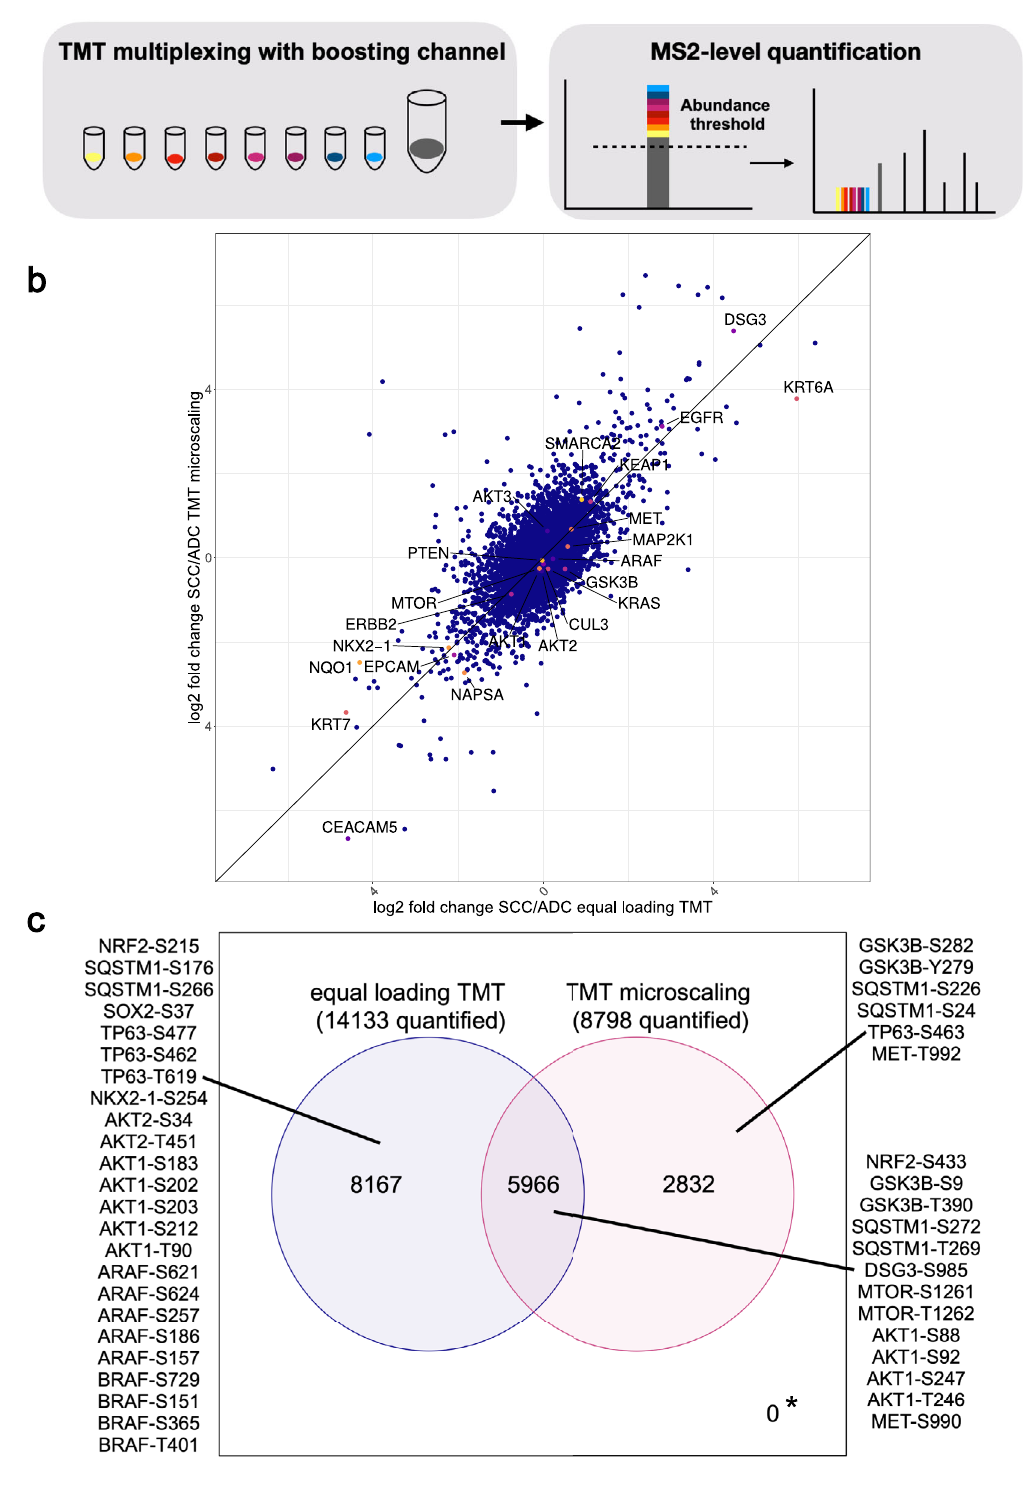
Fig. 4 Deep proteome coverage even from small sample amounts by using a TMT booster sample. a TMT11 combined with a boosting channel allows for microscaled deep proteome and phosphoproteome analysis of FFPE samples with low sample amounts (20 µ g per sample). b Correlation of log2 fold changes of equal loading TMT and micoscaled TMT experiments in FFPE lung cancer samples shows similar quanti fi cation results (Pearson correlation coef fi cient r = 0.67, p < 0.01). NSCLC-relevant proteins are highlighted, all other proteins are shown in blue. Source data are provided as a Source Data fi le. c Venn diagram showing the overlap in quanti fi ed phosphosites between equal loading TMT and microscaled TMT with highlighted phosphosites on NSCLC-relevant proteins and oncogenes. * marks phosphosites not quanti fi ed with either method